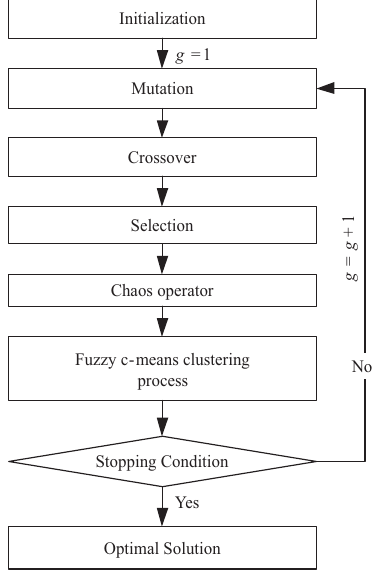
Fig. 1. Fuzzy clustering chaotic based differential evolution